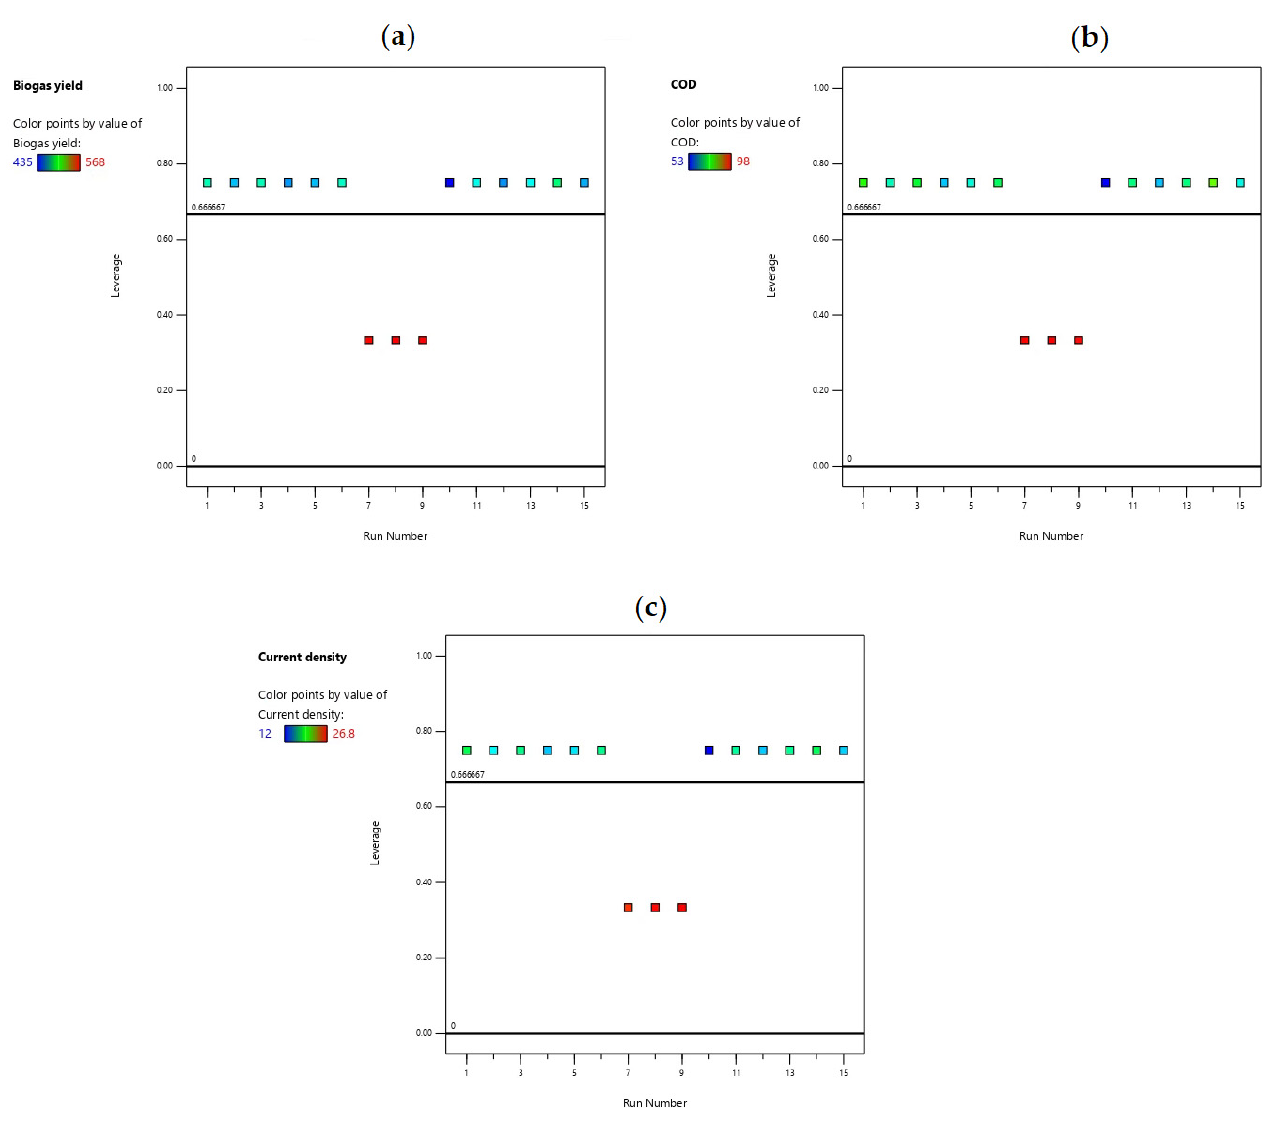
Figure 3. Leverage versus run for ( a ) biogas yield; ( b ) %COD removal; and ( c ) current density. The alpha value ( ∝ ) is 0.05 while the total number of experimental runs (N er ) is 15. Therefore, according to Equation (8), the tail value is